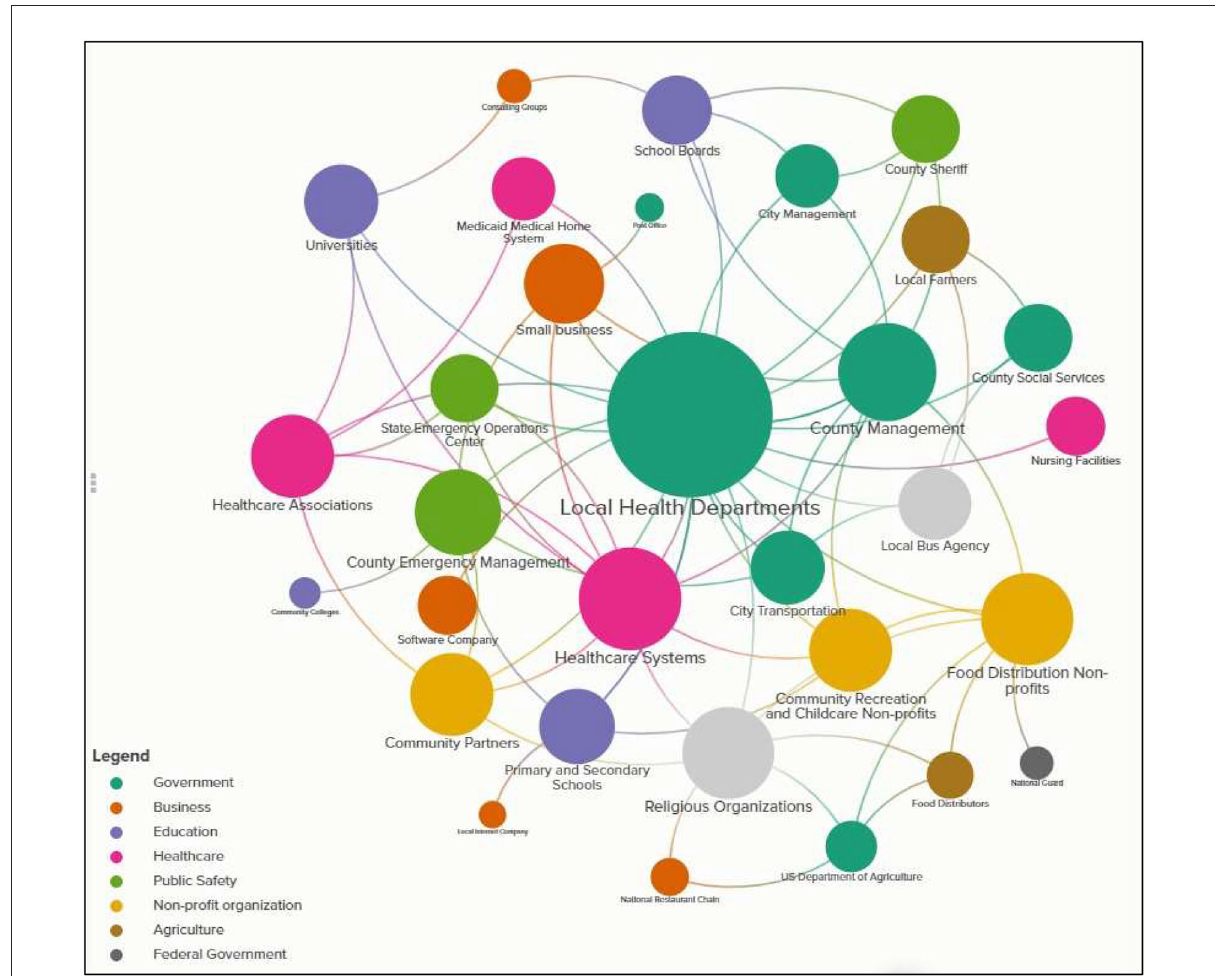
FIGURE1 Network map of cross-sector partnerships formed in North Carolina’s local COVID-19 pandemic response. This figure shows the network map developed from the collaboration described by interviewees. Each node in the map represents an organization type, color-coded by sector and sized by closeness metric (larger nodes more connected to other nodes in the network map). A full, interactive network map can be found